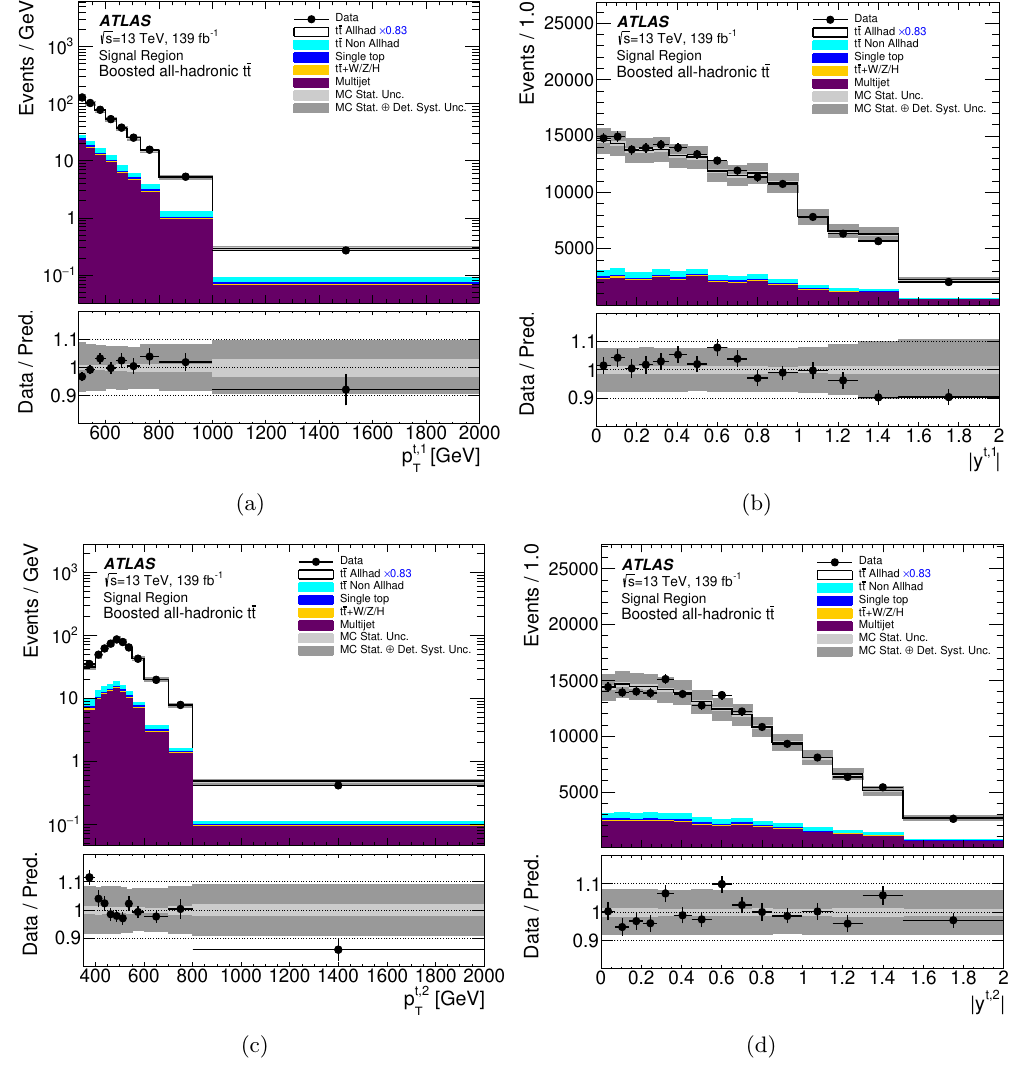
Figure 4 . Kinematic distributions of top-quark-candidate jets in the signal region: (a) p T and (b) | y | of the leading jet, and (c) p T and (d) | y | of the second-leading jet. The signal prediction (open histogram) is based on the Powheg + Pythia 8 t ¯ t calculation normalized to the observed yield. The background (solid histogram) is the sum of the data-driven multijet estimate and the MC- based expectation for the contributions of non-all-hadronic t ¯ t , single-top-quark, and t ¯ t + W/Z/H processes. The light grey bands indicate the statistical uncertainties and the dark grey bands indicate the combined statistical and detector-related systematic uncertainties defined in section